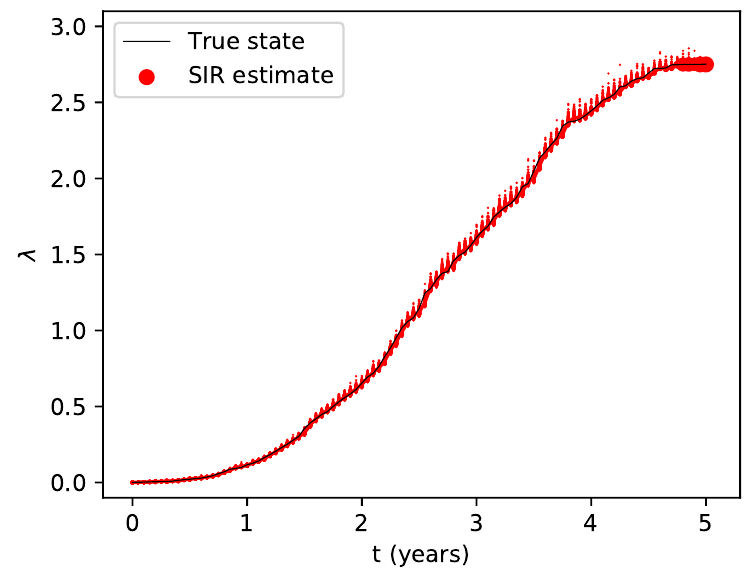
Figure 6. Degradation state online estimation with time-varying pump power—a priori distribution (dot size represents particle weight).